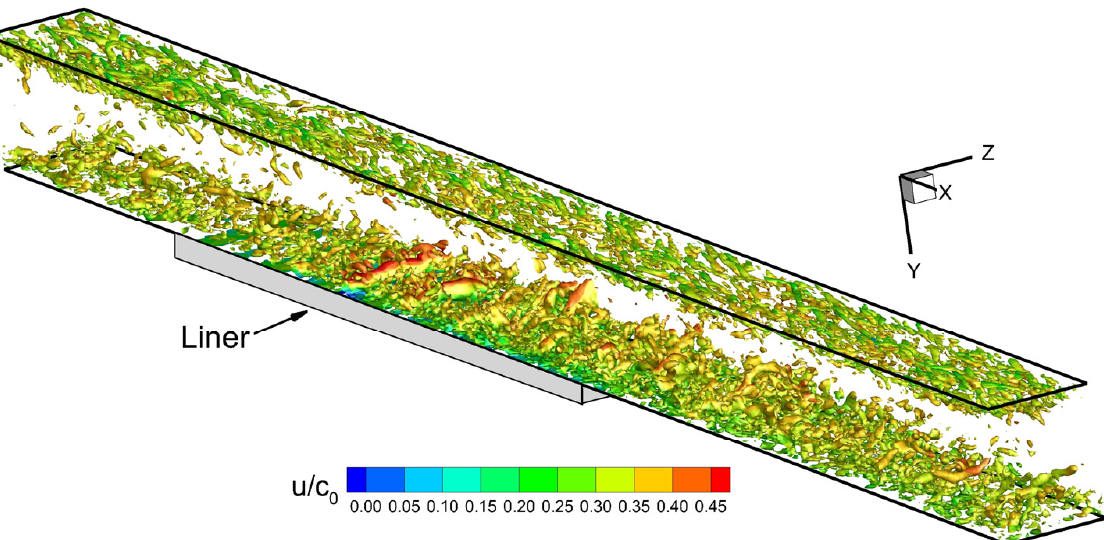
Figure 23. Instantaneous iso-surface of swirl parameter (magnitude of the second eigenvalue of the